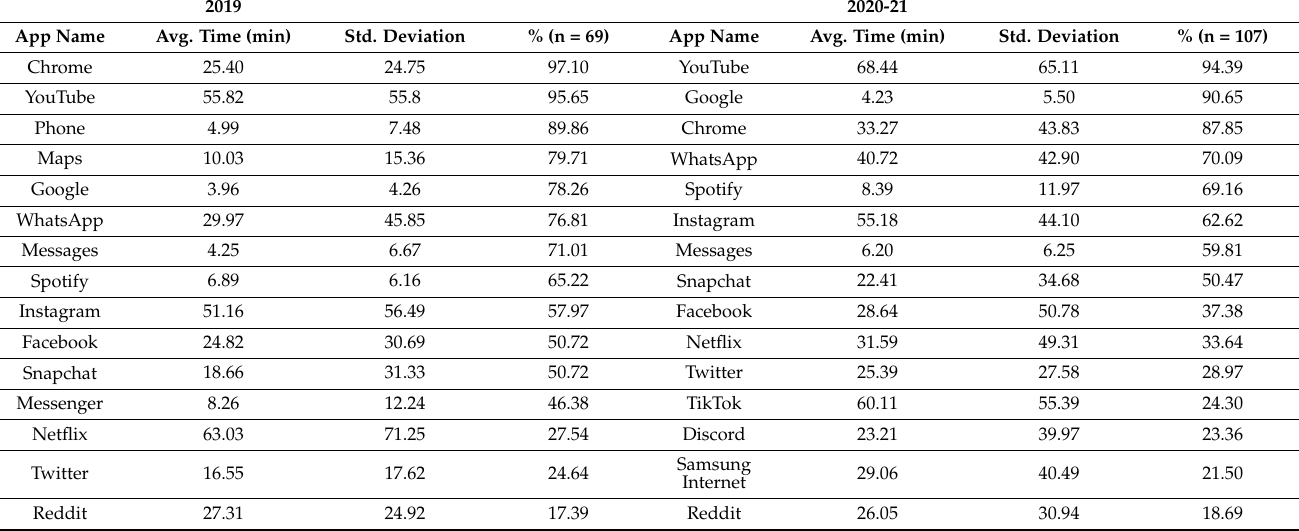
Table 7. Top 15 apps used by emerging adult users based on time spent in minutes in 2019